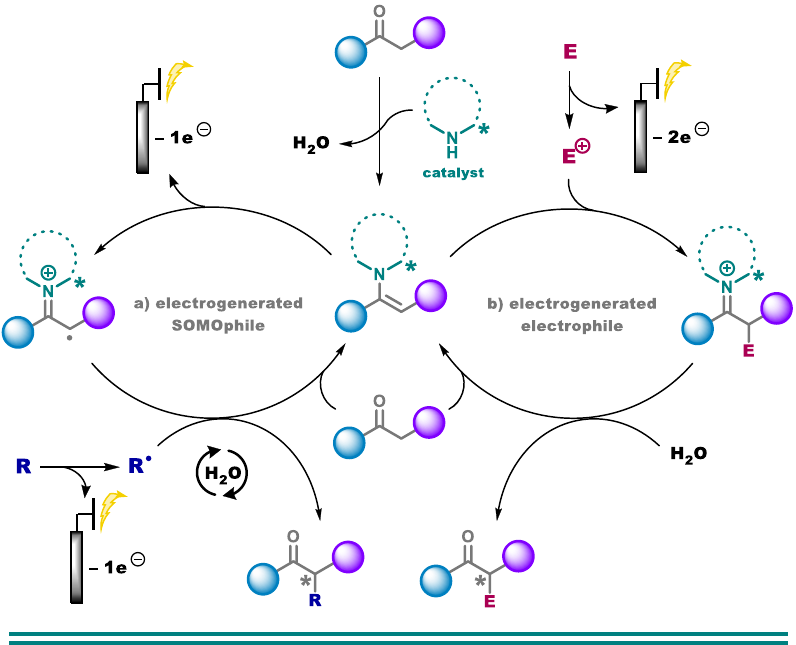
Figure 2. Two design principles for α-functionalization of carbonyl compounds in electrooxidative enamine catalysis: ( a ) electrogenerated SOMOphile; ( b ) electrogenerated electrophile.